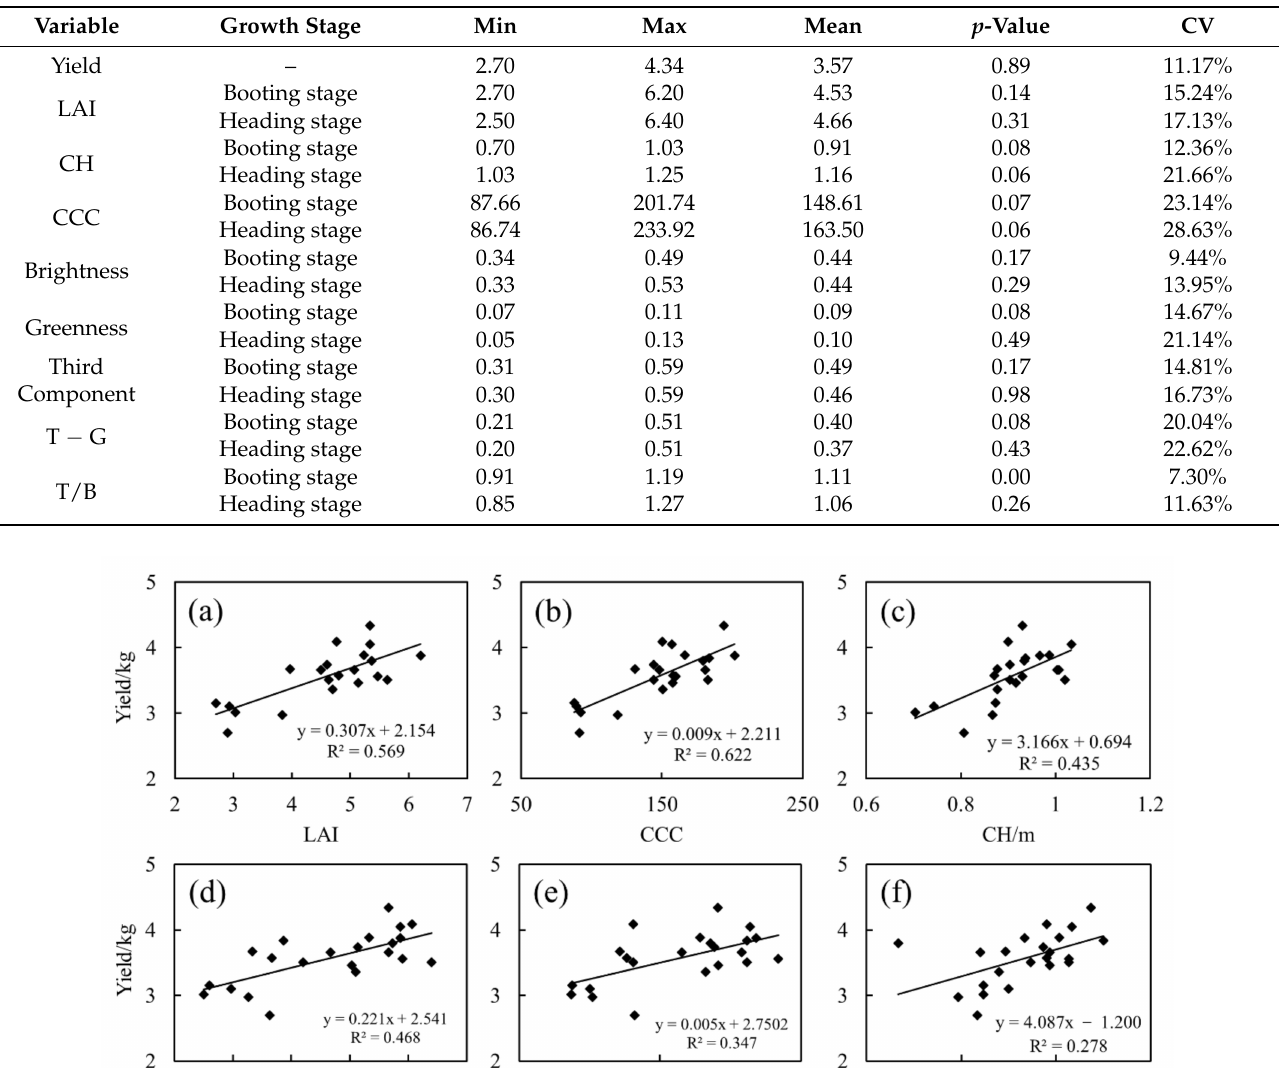
Table 2. Data description and normality test.